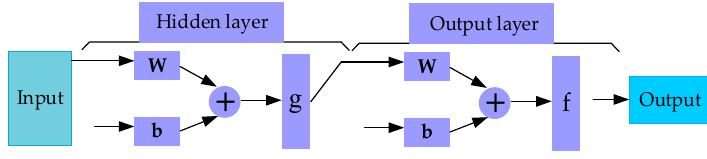
Figure 2. The schematic diagram of the BP-ANN.